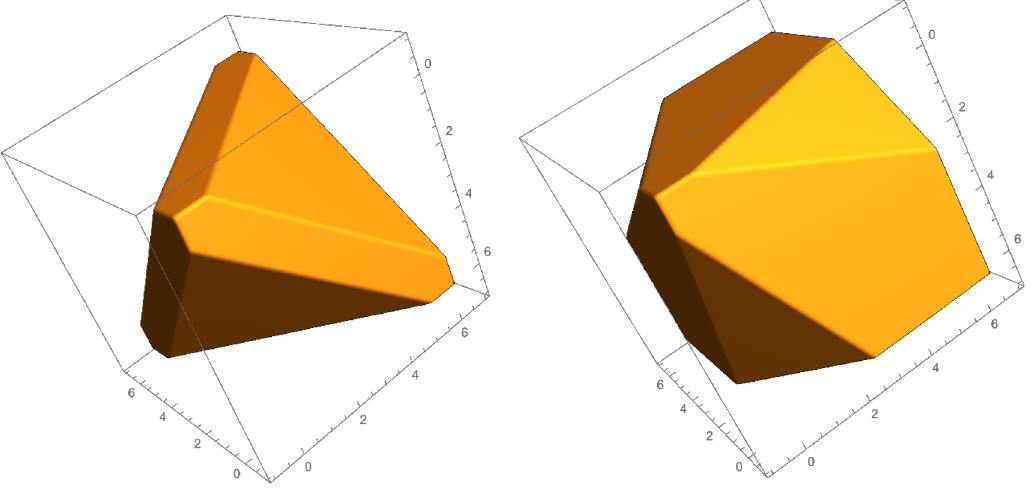
Figure 5 . The left figure corresponds to the undeformed geometry, A 6 [(1 , 2) , (3 , 4) , (5 , 6)] , given by restriction equations in section 2. The right figure corresponds to the deformed geometry, A 0 [(1 , 2) , (3 , 4) , (5 , 6)] , with α i,j = 2 . Note that the geometry is unbounded in both images and can 6 be visualized as a cone with additional